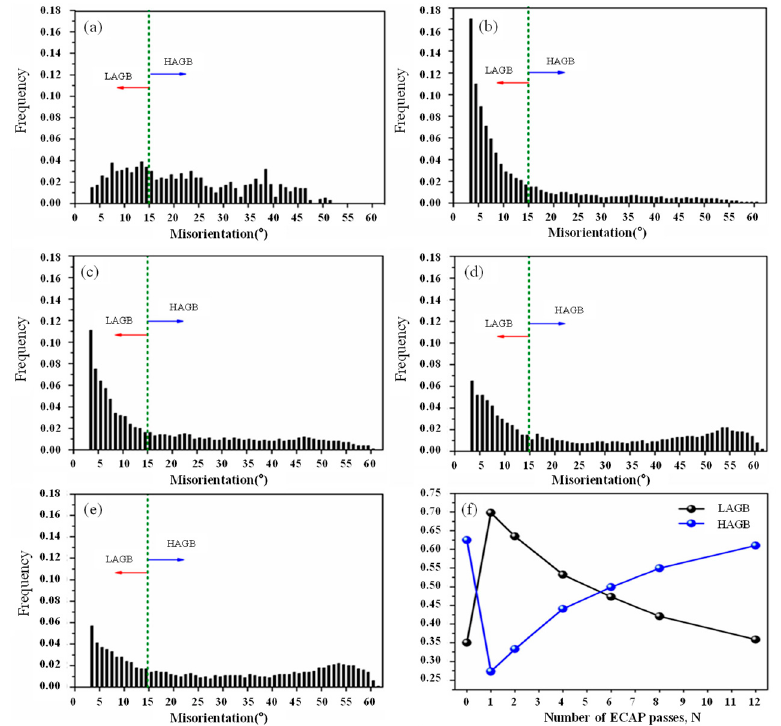
Figure 16. Variation of angular grain boundary of aluminum alloy after different passes [98]: ( a ) zero pass; ( b ) one pass; ( c ) four passes; ( d ) eight passes; ( e ) twelve passes; ( f ) is the angular grain boundary variation curve of different passes. Reproduced with permission from Springer Nature.